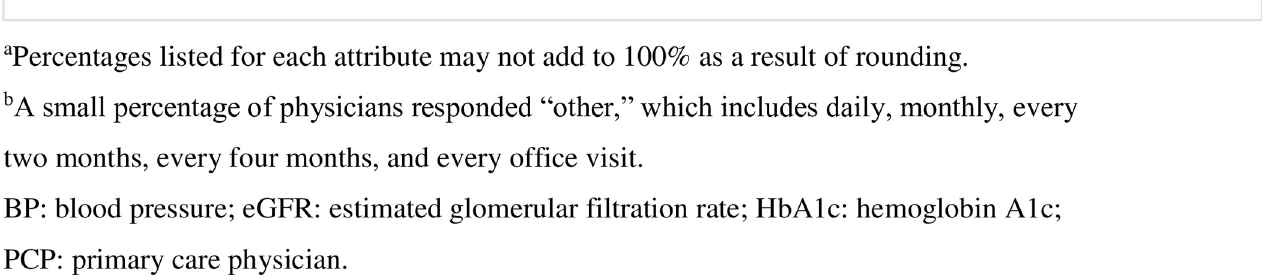
PLOS ONE | https://doi.org/10.1371/journal.pone.0271740 August 1,